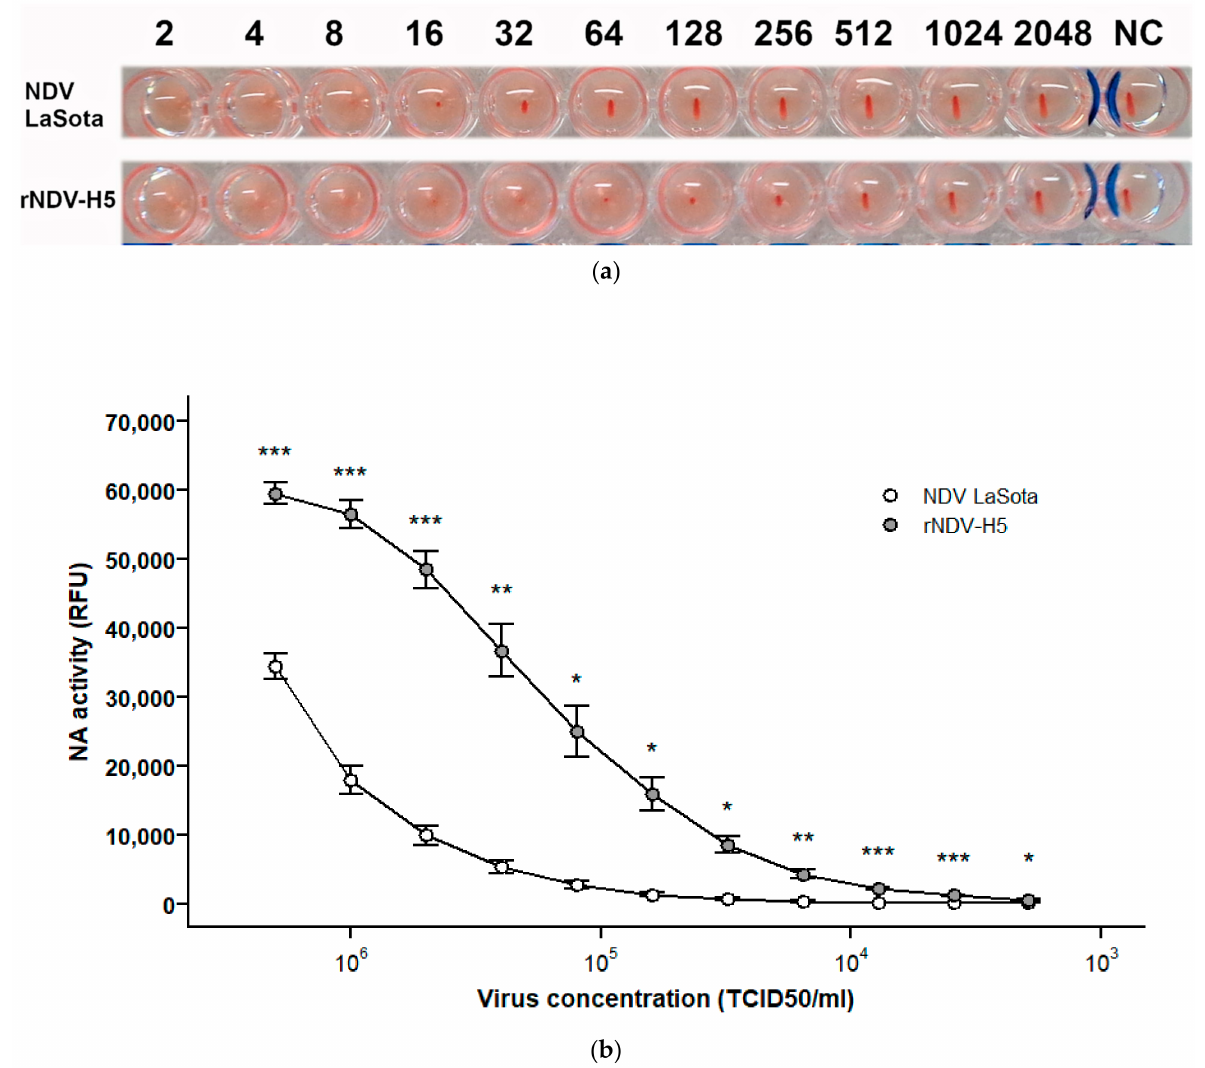
Figure 2. Hemagglutinating and neuraminidase activities of NDV LaSota and rNDV-H5. ( a ) Hemagglutination of chicken erythrocytes by two-fold serially diluted NDV LaSota (107 TCID50/mL) and rNDV-H5 (107 TCID50/mL). NC, negative control. ( b ) Neuraminidase activity of two-fold serially diluted NDV LaSota and rNDV-H5 viruses starting at a titer of 10 7 TCID50/mL.* p < 0.05, ** p < 0.01, *** p <